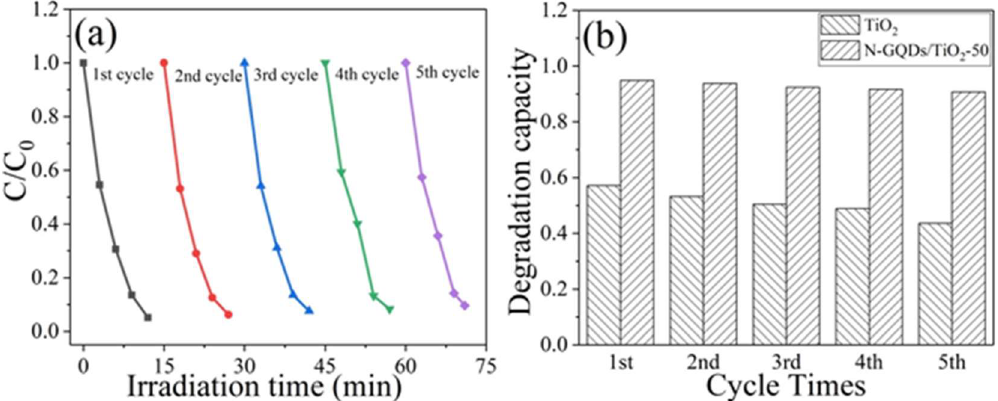
Figure 7. ( a ) Recycle stability of the photocatalytic decomposition of MO by N-GQDs/TiO 2 -50. ( b ) Repetitive photocatalytic decomposition of MO for TiO 2 and N-GQDs/TiO 2 -50 photocatalysts. Scheme 1 explains the probable mechanism of degradation of MO by N-QGDs/TiO 2